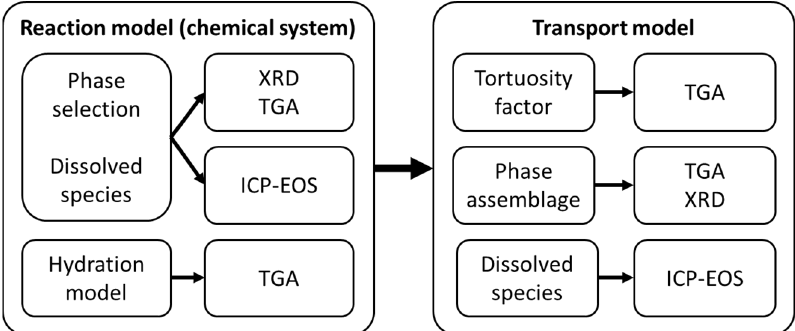
Figure 8. Model validation process, showing the validation of the reaction model (i.e., the chemical system) and the transport model (combined transport and chemistry).